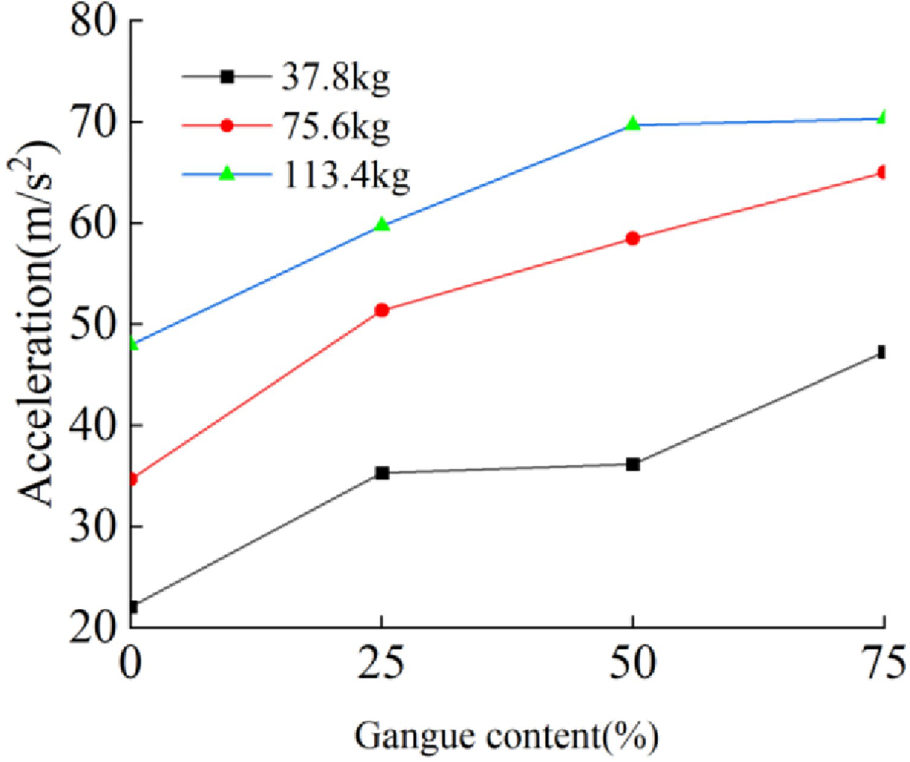
Fig 22. Gangue content versus effective value of acceleration under the mass of 113.4kg, 75.6kg, and